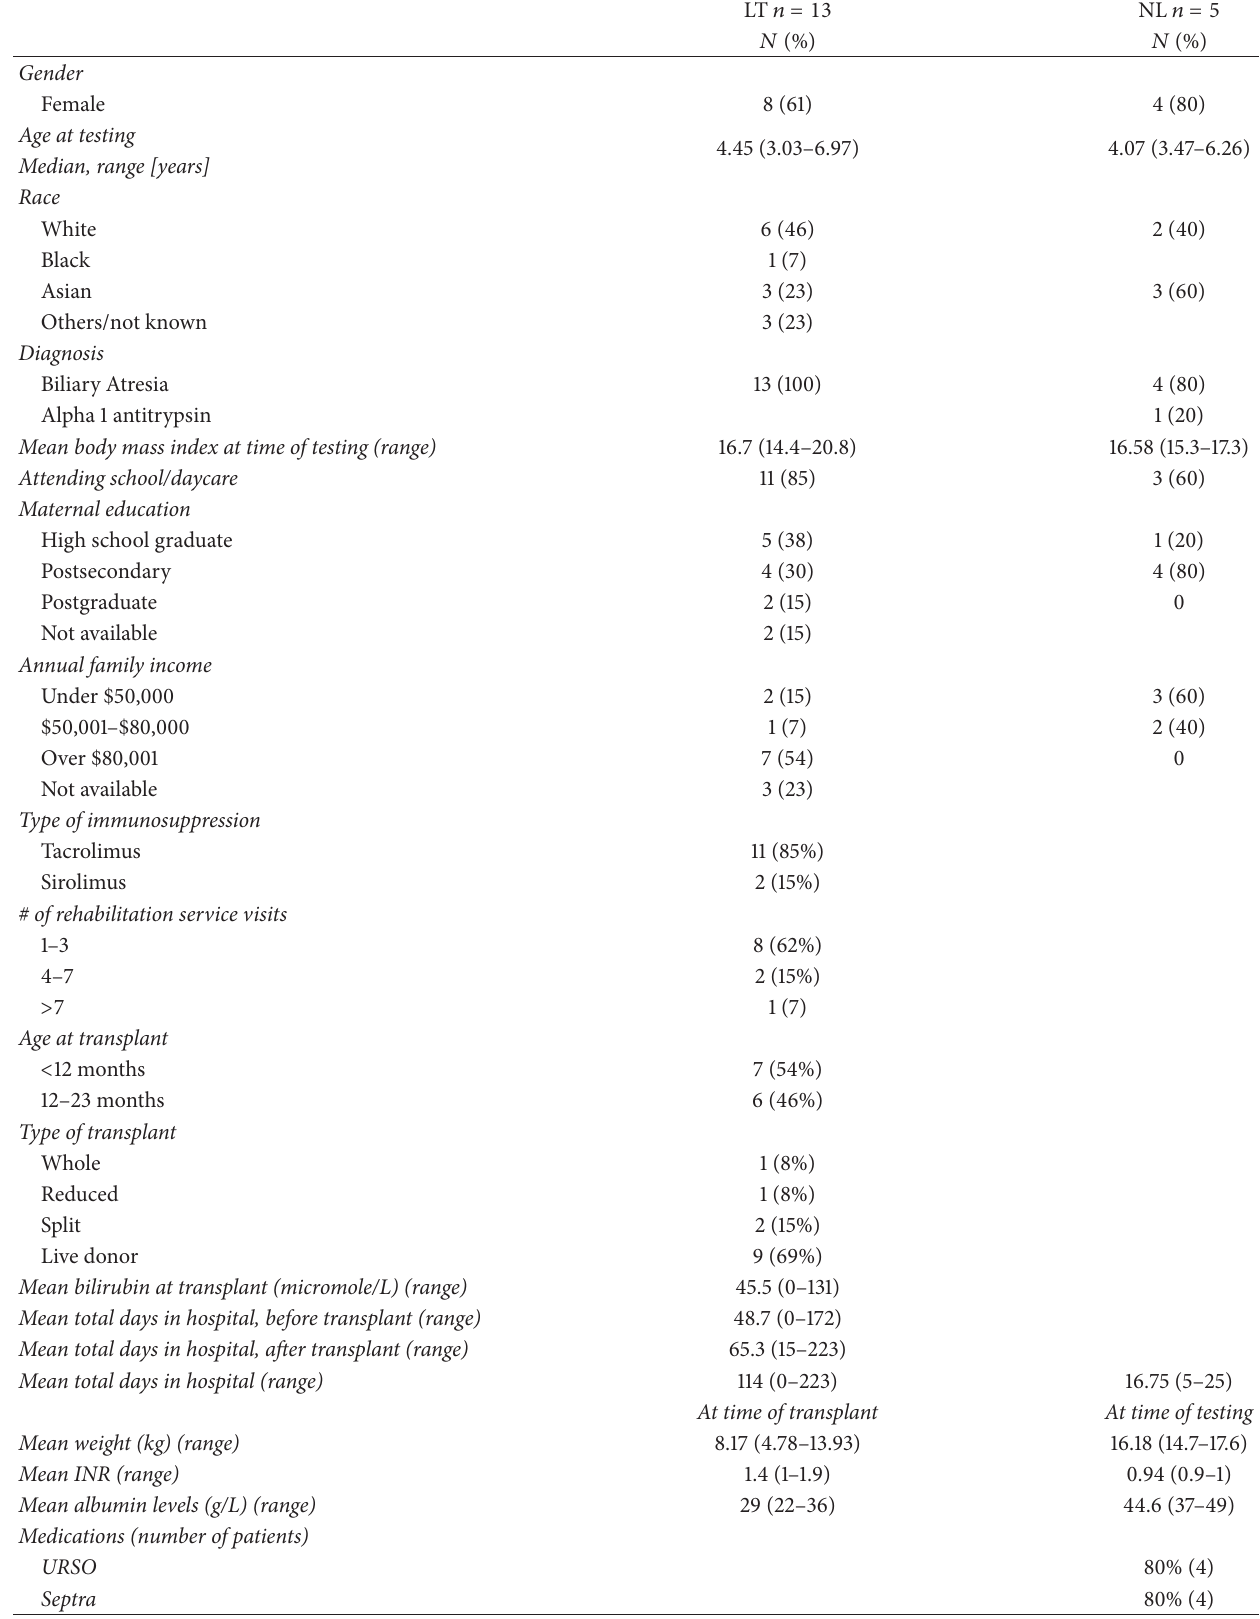
Table 1: Demographic